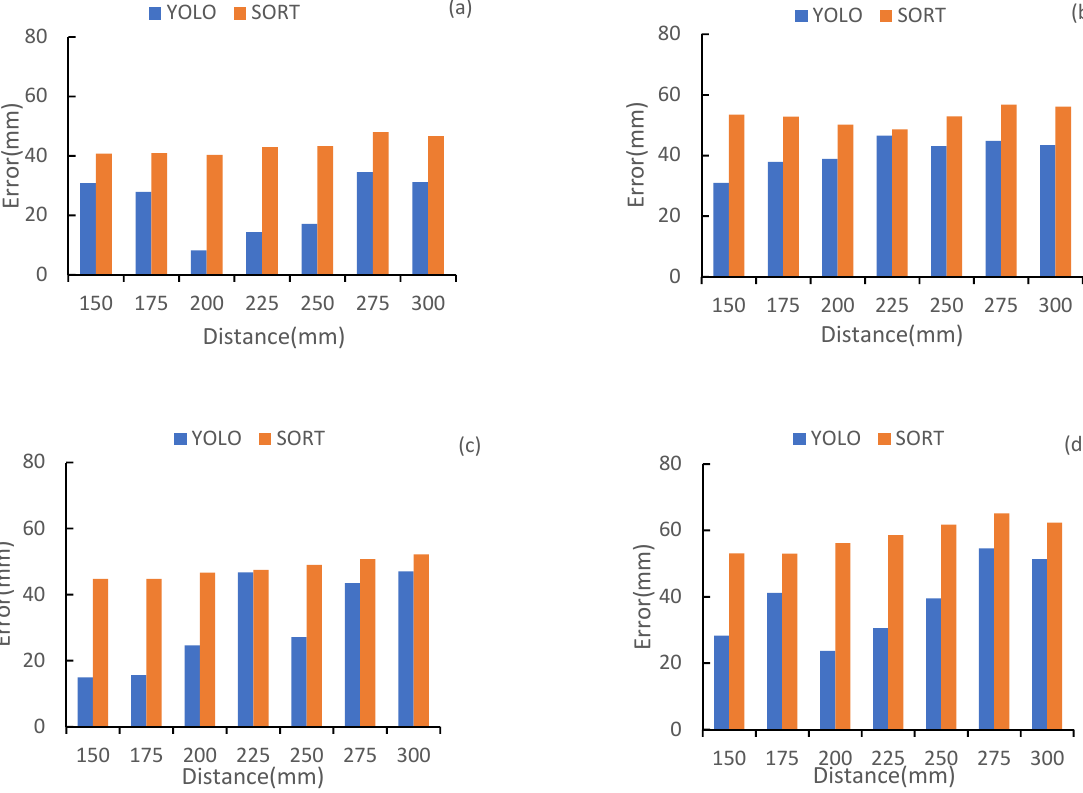
Figure 9. Spatial location error results with YOLO model and SORT model with different z-direction distance. ( a ) 115 mm, ( b ) 120 mm, ( c ) 125 mm, and ( d ) 130 mm.